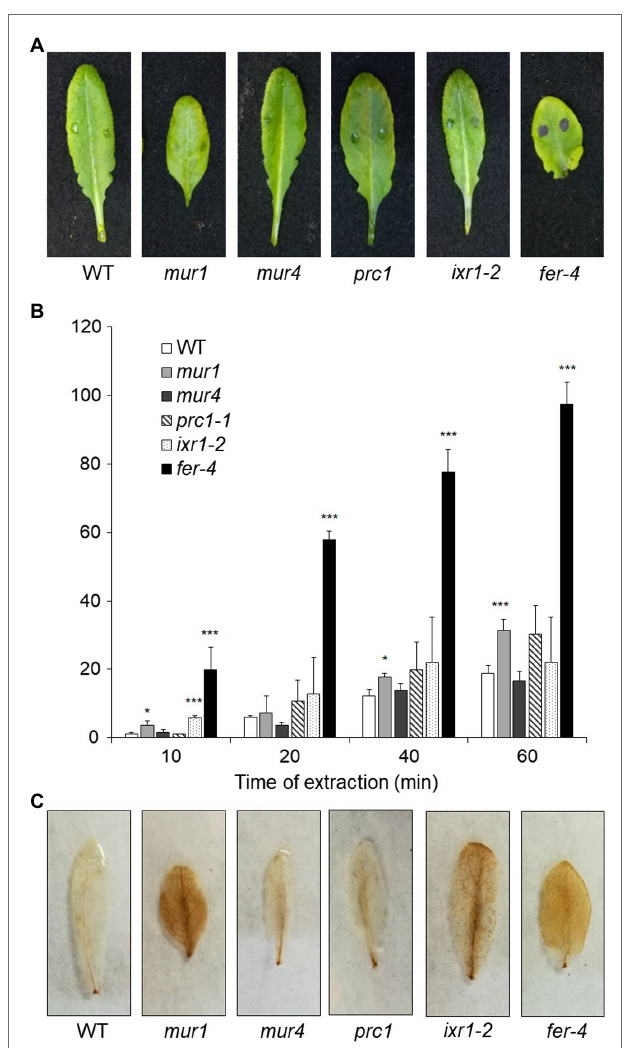
FIGURE 7 | Cuticle permeability and ROS accumulation in mutants with impaired cell wall integrity. (A,B) , Rosette leaves of five-week-old Col-0 (WT), mur1 , mur4 , prc1 , irx1-2 , and fer-4 plants were stained with toluidine blue (A) to assay cuticle permeability or (B) incubated for the indicated times with 80% EtOH, and the concentration of chlorophyll leaked in the medium and of total chlorophyll was spectrophotometrically measured. Bars in (B) indicate average percentage of total chlorophyll leaked at the indicated time of incubation ± SD ( n = 3). For each time point, asterisks indicate statistically significant differences with the control-treated WT samples, according to Student’s t-test (*** p < 0.01; * p < 0.01). (C) , rosette leaves as in (A,B) were stained with DAB for ROS accumulation. These experiments were repeated three times with similar results.